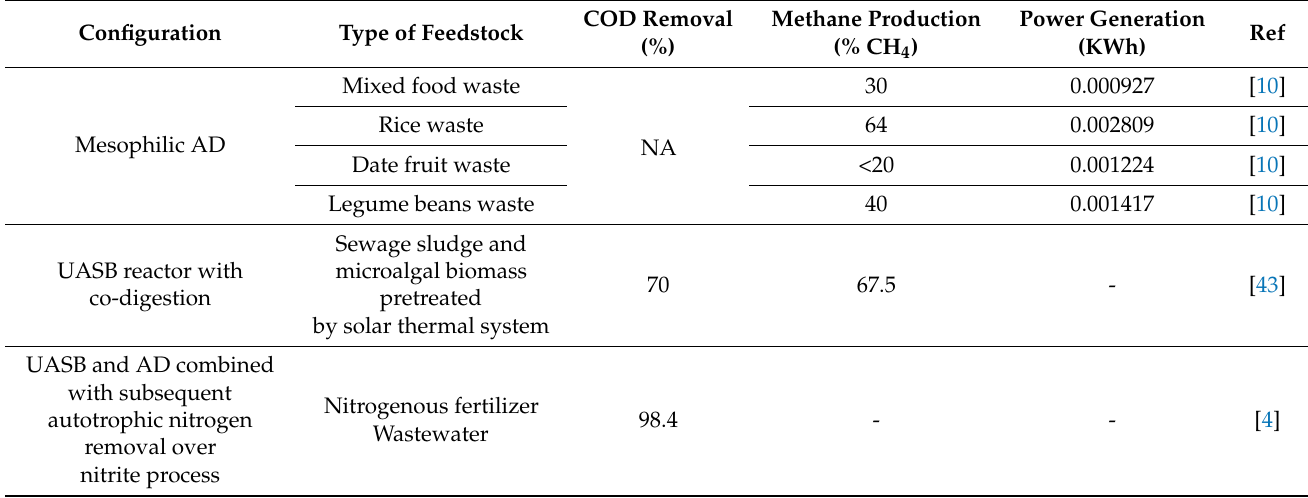
Figure 3. ( A ) and ( B ) represent TSS, VSS and COD removal from primary sludge; ( C ) and ( D ) represent TSS, VSS and COD removal from mixed sludge. Table 2. Comparisons of methane production and power generation from various substrates in the